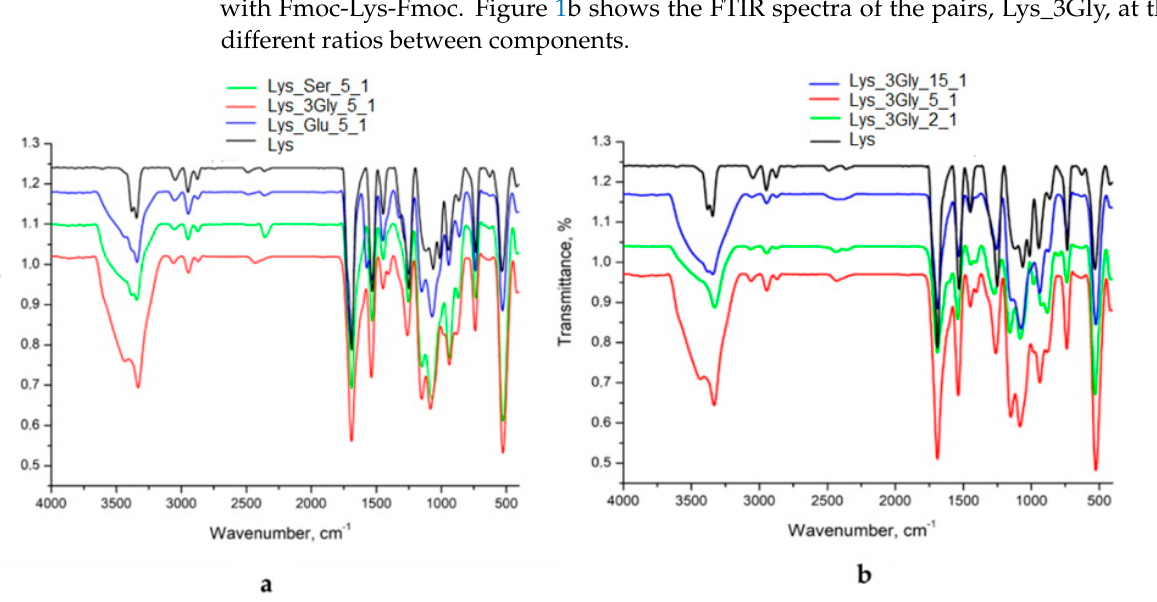
Figure 1. FTIR spectra of ( a ) the amino acid/peptide systems that formed supramolecular gels (at a constant ratio of 5_1) and ( b ) the pairs, Lys_3Gly, at different ratios between components .